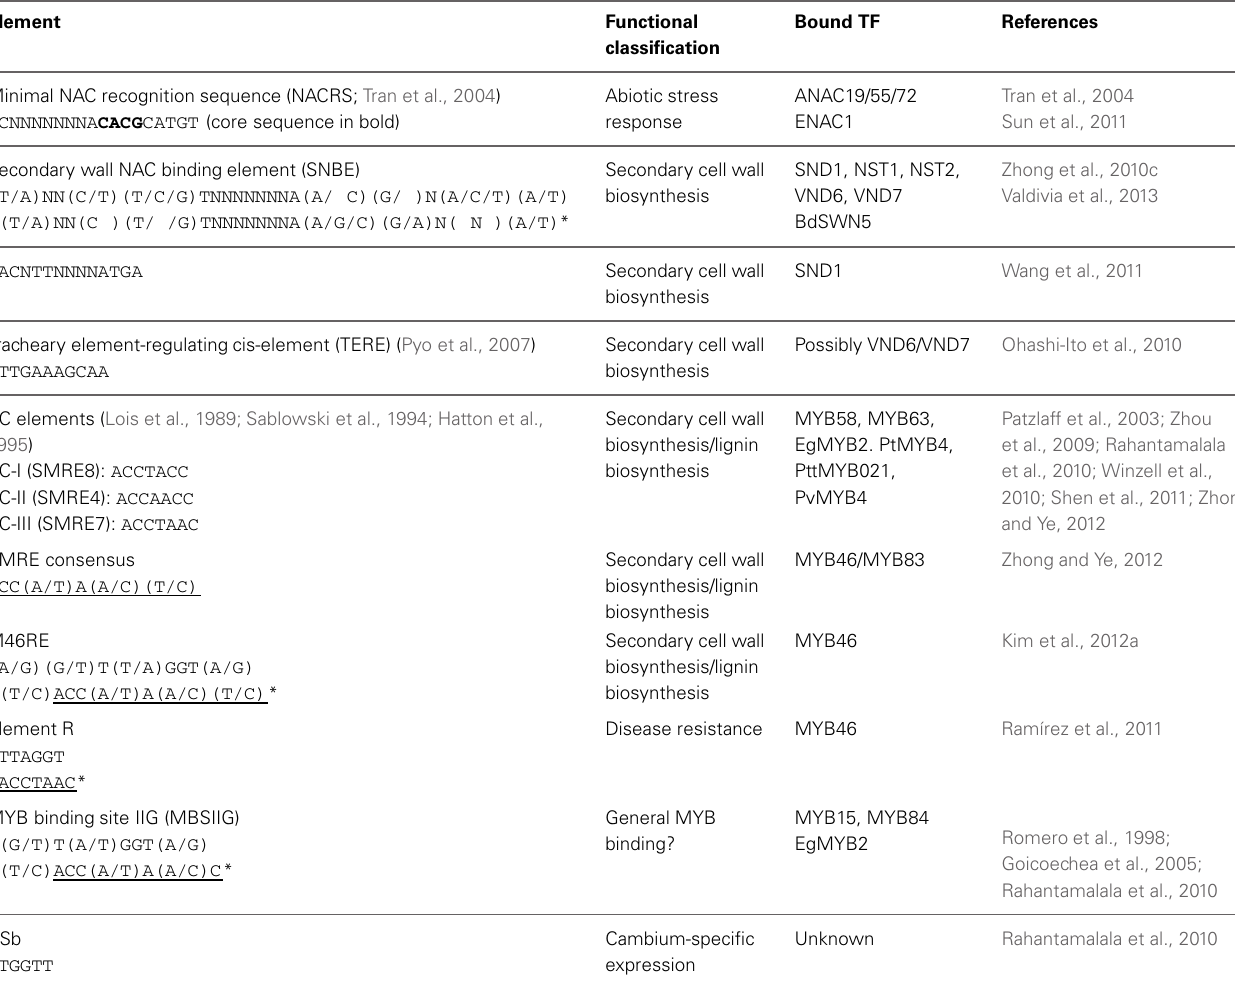
Table 1 | Cis -regulatory elements that have been linked to SCW biosynthesis or which serve as general binding motifs for TF families involved in SCW transcriptional